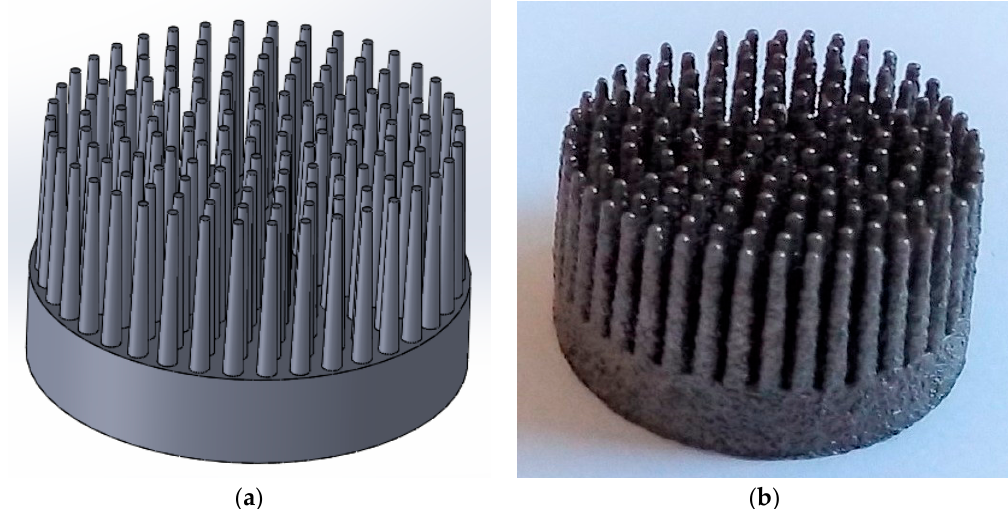
Figure 2. ( a ) Computer-assisted design (CAD) model of MSC-Scaffold prototypes for RA endoprostheses; ( b ) The MSC- Scaffold prototype selective laser melting (SLM) manufactured of Ti-6Al-4V alloy on the base of the CAD models.